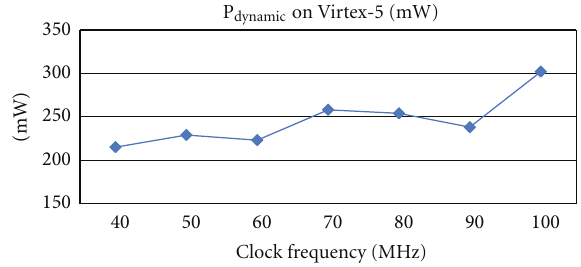
Figure 19: Impact of the clock frequency to the dynamic power consumption of a uniprocessor design on a V5LX110T.